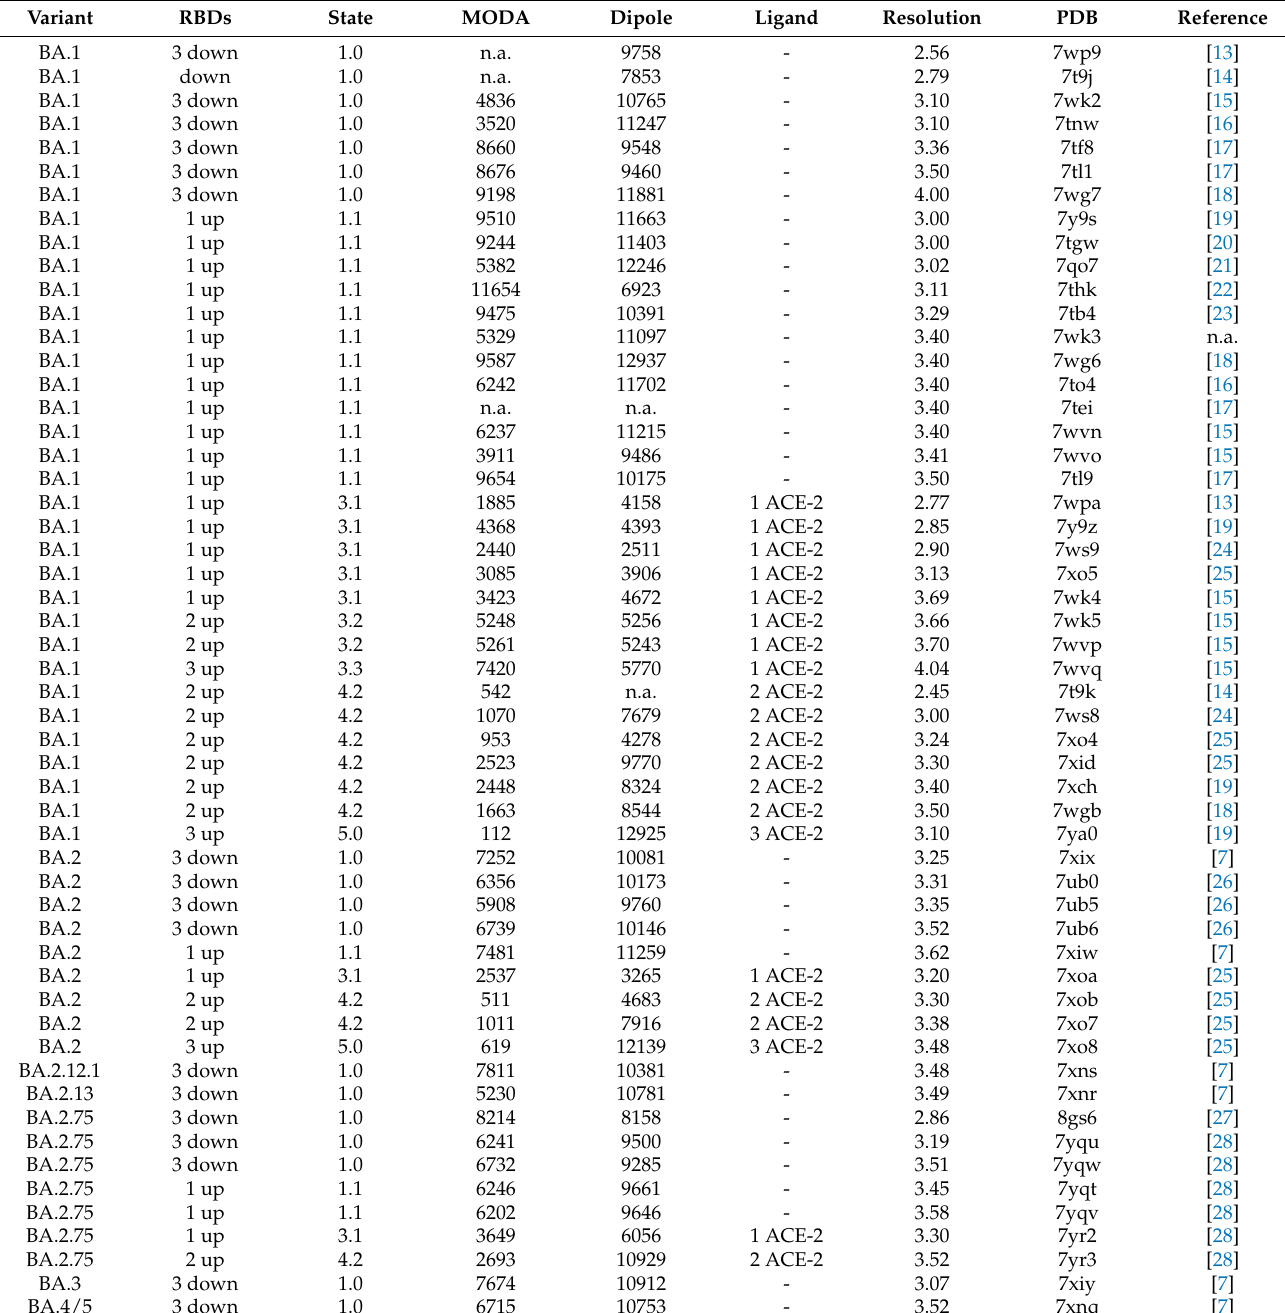
Table 2. Structures of SARS-CoV-2 Omicron subvariant spikes. All the higher resolution structures of the free ectodomain trimer and its ACE-2 complexes that are available in the PDB are listed, as are the RBD orientations, spike conformational state (Figure 1), average MODA score of the 3 RBD modules, dipole moment (Debyes) of the S ectodomain (unless “n.a.” which indicates insufficient data), numbers of bound ACE-2 molecules, resolution (Å), PDB code, and